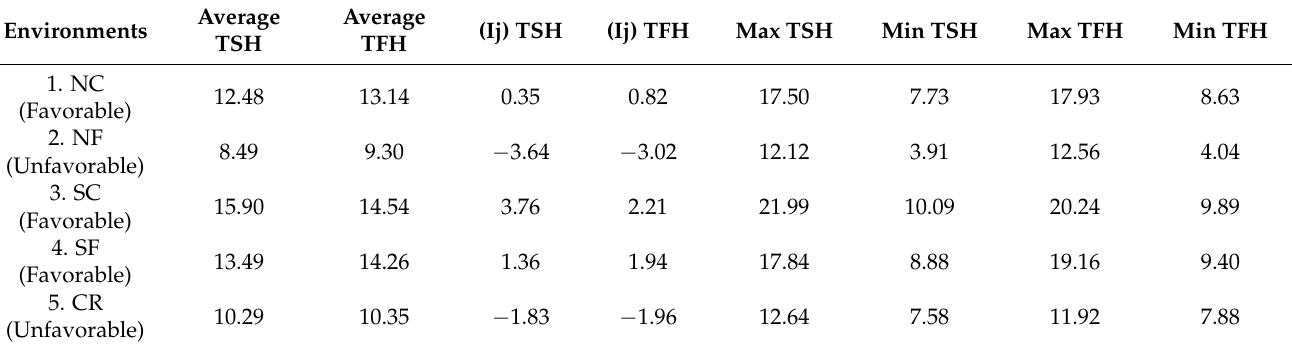
Table 6. Classification of sugarcane microregions using environmental index (Linear regression and Centroid method) in the evaluation of 20 sugarcane genotypes for TSH and TFH.